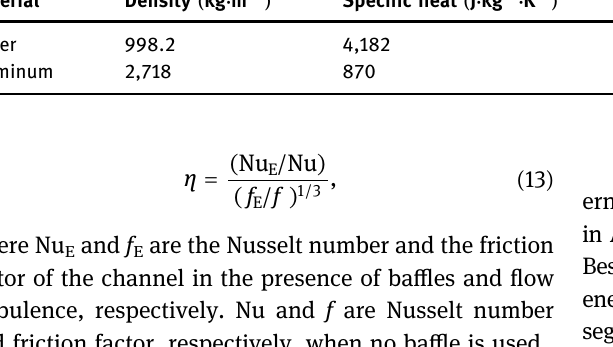
Table 1: The thermophysical properties of water and material Material